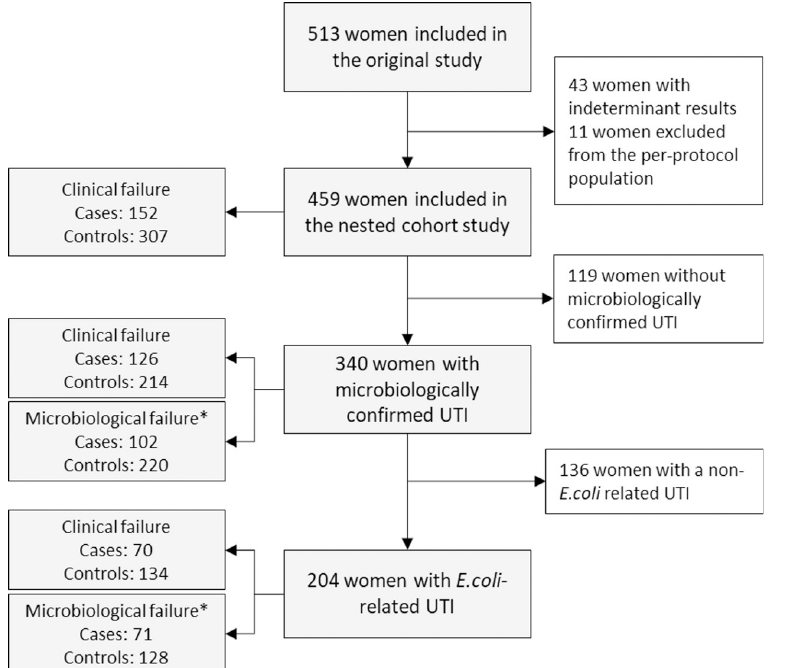
Fig 1. Study flowchart. � Negative or missing cultures at baseline were